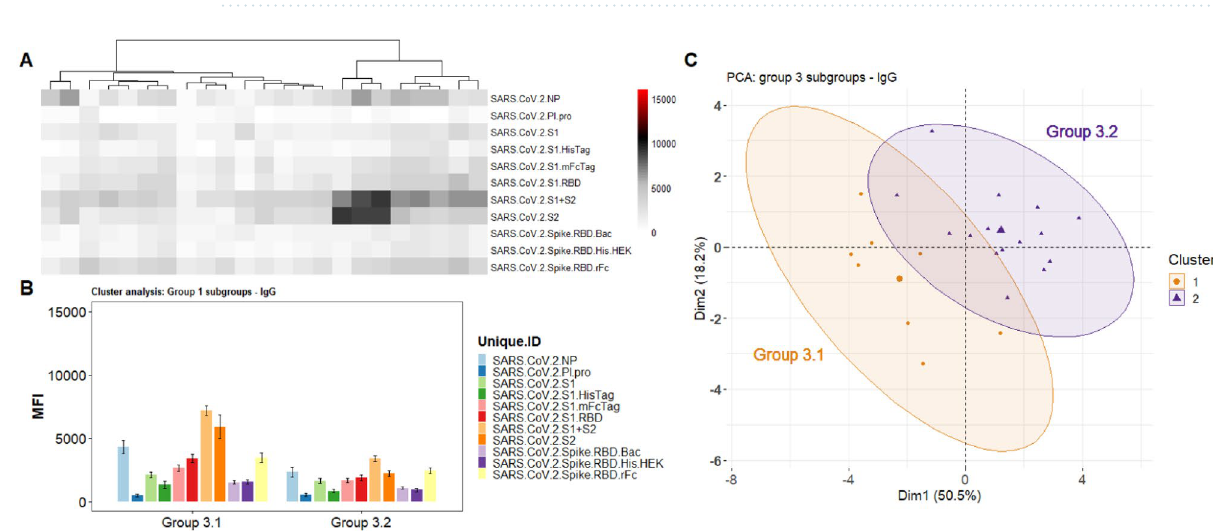
Figure 5. Group 2 Cluster Analysis and PCA demonstrates two subgroups. ( A ) Heatmap showing the reactivity to the SARS-CoV-2 antigens. Samples were clustered using the hierarchical clustering analysis. The dendrogram was cut (and color coded) to a final cluster number equal 3. ( B ) A bar graph showing the mean reactivity and the standard error of each cluster to each individual SARS-CoV-2 antigen. ( C ) PCA analysis showing the spatial distribution of the samples categorized as subgroups 2.1 and 2.2 for the first and second principal components. This figure was generated using the R programing language, version 4.0.2 (https:// www.r- proje ct. org/).